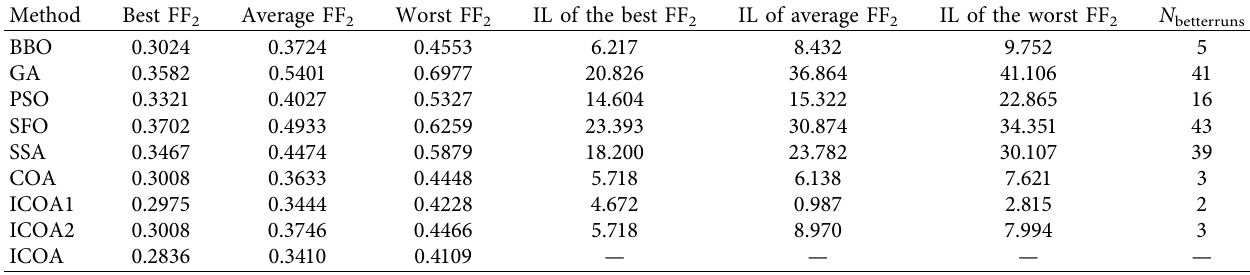
Table 6: The comparison among nine methods of the IEEE 33-bus distribution network for the second case. Method